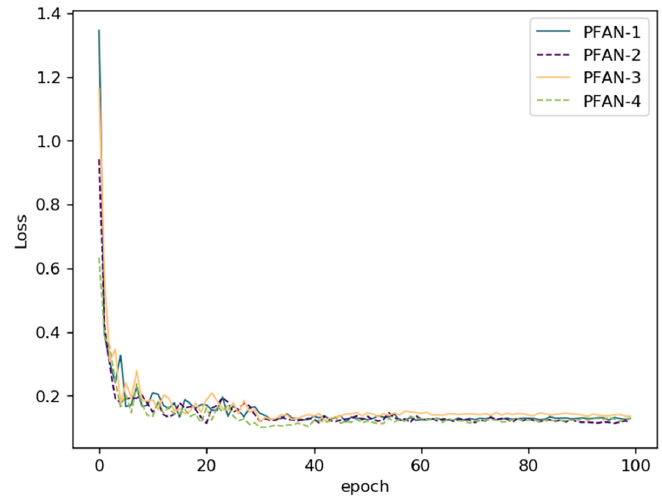
Figure 11. The training loss curves on GTSRB in the ablation study.